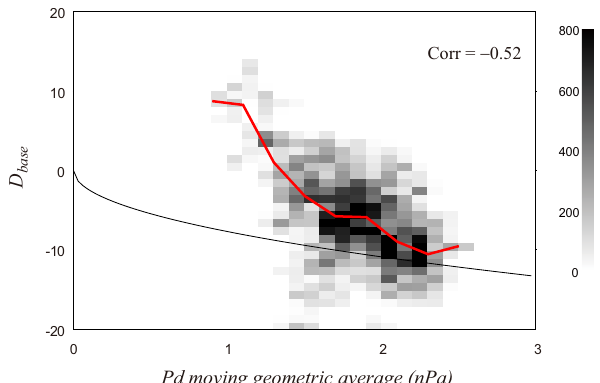
Fig. 7. Two-dimensional histograms comparing D base and the 30- day moving geometric averages of solar-wind dynamic pressure. The correlation coefficient was − 0.52. The red solid line indicates the median for each interval of 0.2nPa. The black solid line indi- √ P d (see cates the line of − 7 . 7